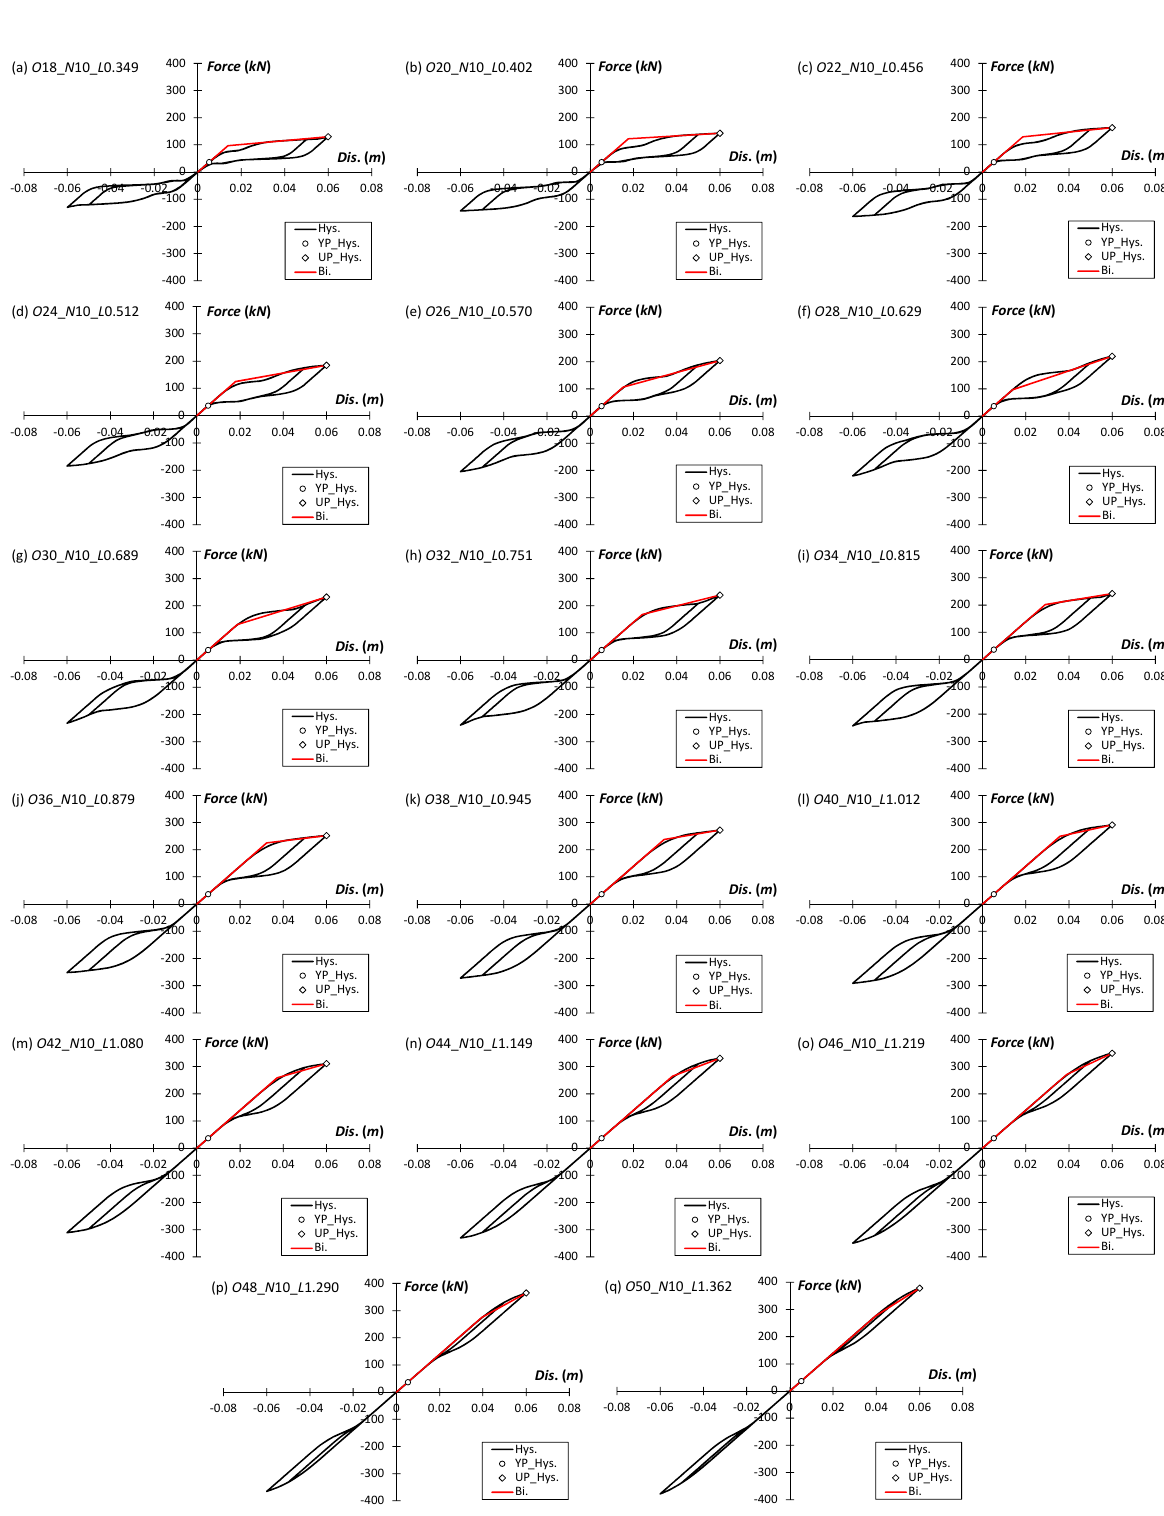
Figure 12. Typical hysteresis curves of SMA-BHD numerical models with 10 numbers of bars of different cross-sectional diameters in Set 1: ( a ) Φ 18; ( b ) Φ 20; ( c ) Φ 22; ( d ) Φ 24; ( e ) Φ 26; ( f ) Φ 28; ( g ) Φ 30; ( h ) Φ 32; ( i ) Φ 34; ( j ) Φ 36; ( k ) Φ 38; ( l ) Φ 40; ( m ) Φ 42; ( n ) Φ 44; ( o ) Φ 46 ; ( p ) Φ 48 and ( q ) Φ 50.